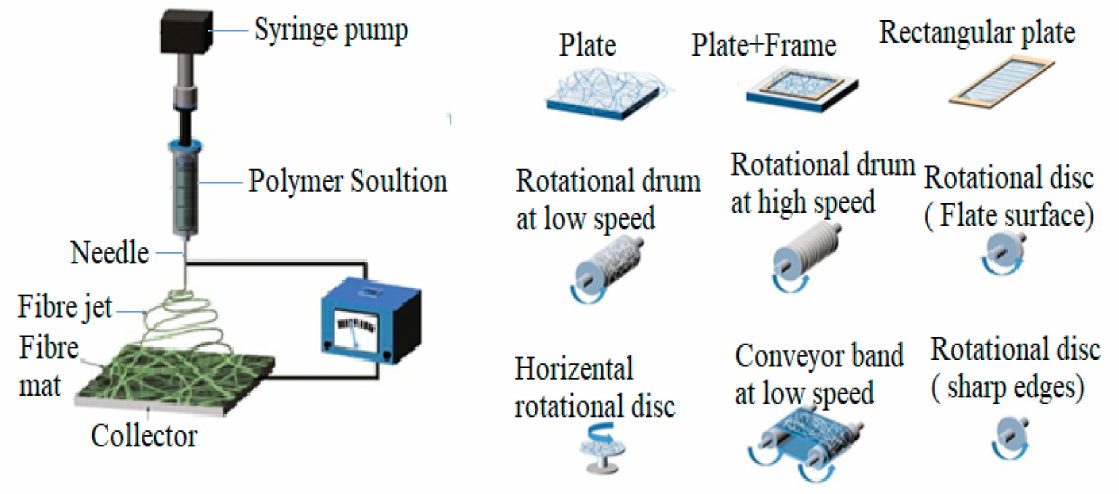
Figure 1. Principle electrospinning setup and collector types [15], while rotating collectors can reduce the randomness of the